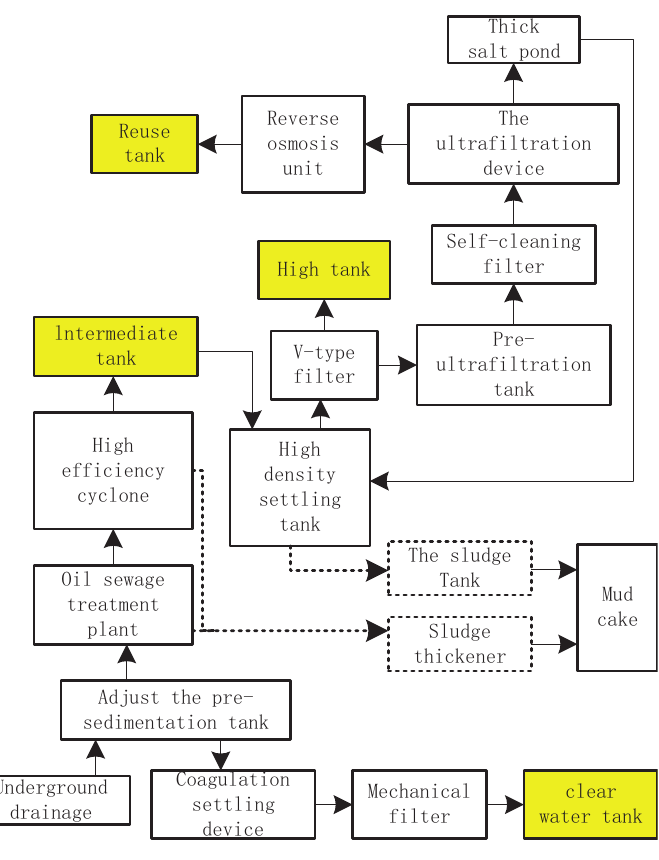
Figure 1. Flow chart of mine water treatment